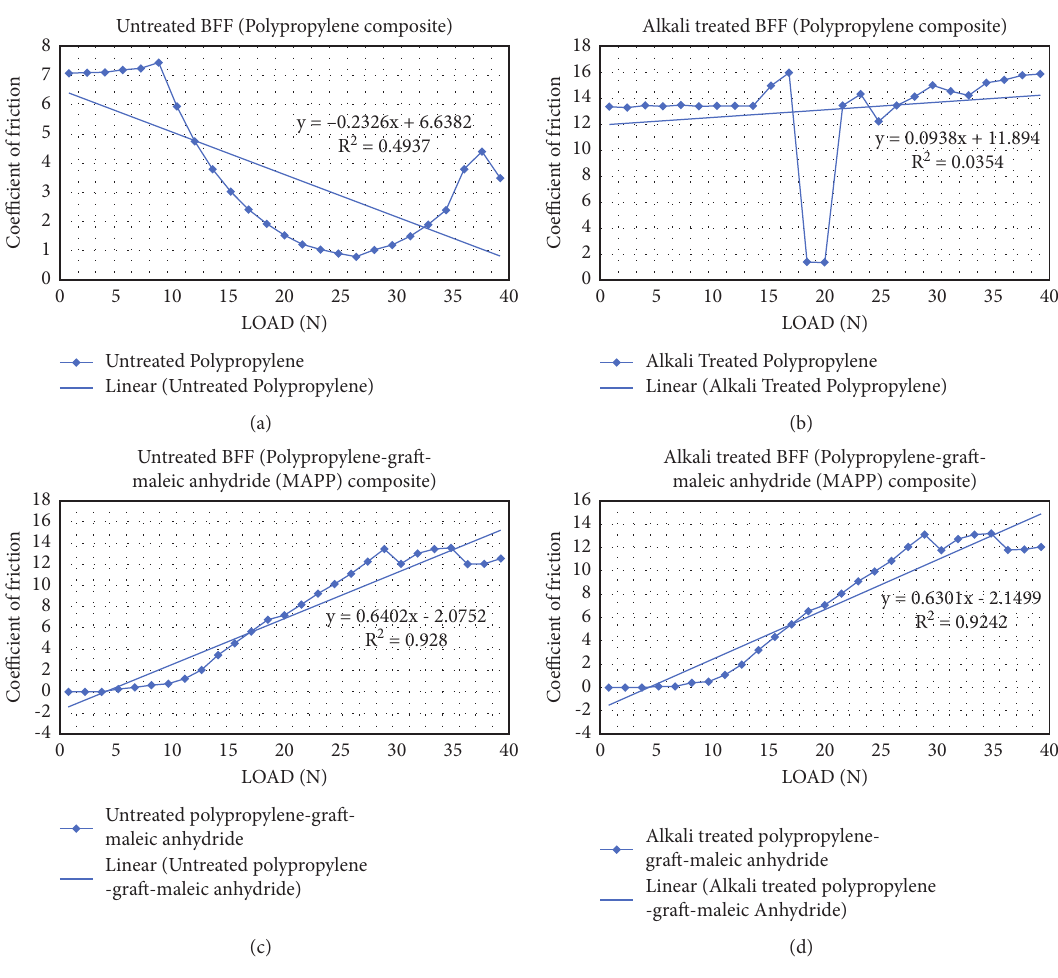
Figure 9: (a–d) Coefficient of friction versus applied load of specimens at varying load and sliding distance 4000m. Table 1: Particulars of BFF/PP composite specimens and sliding